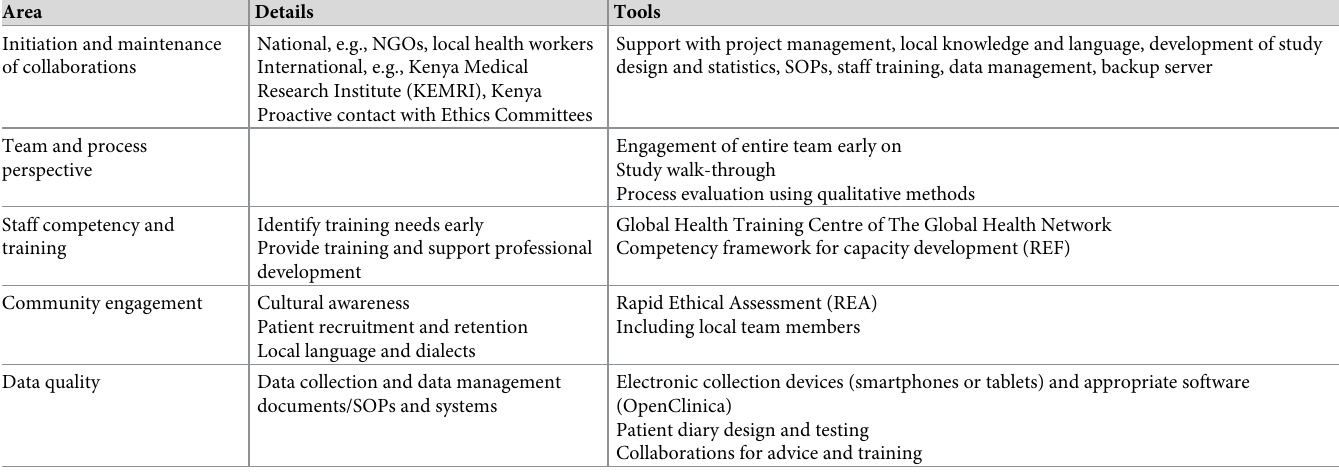
Table 1. Summary of